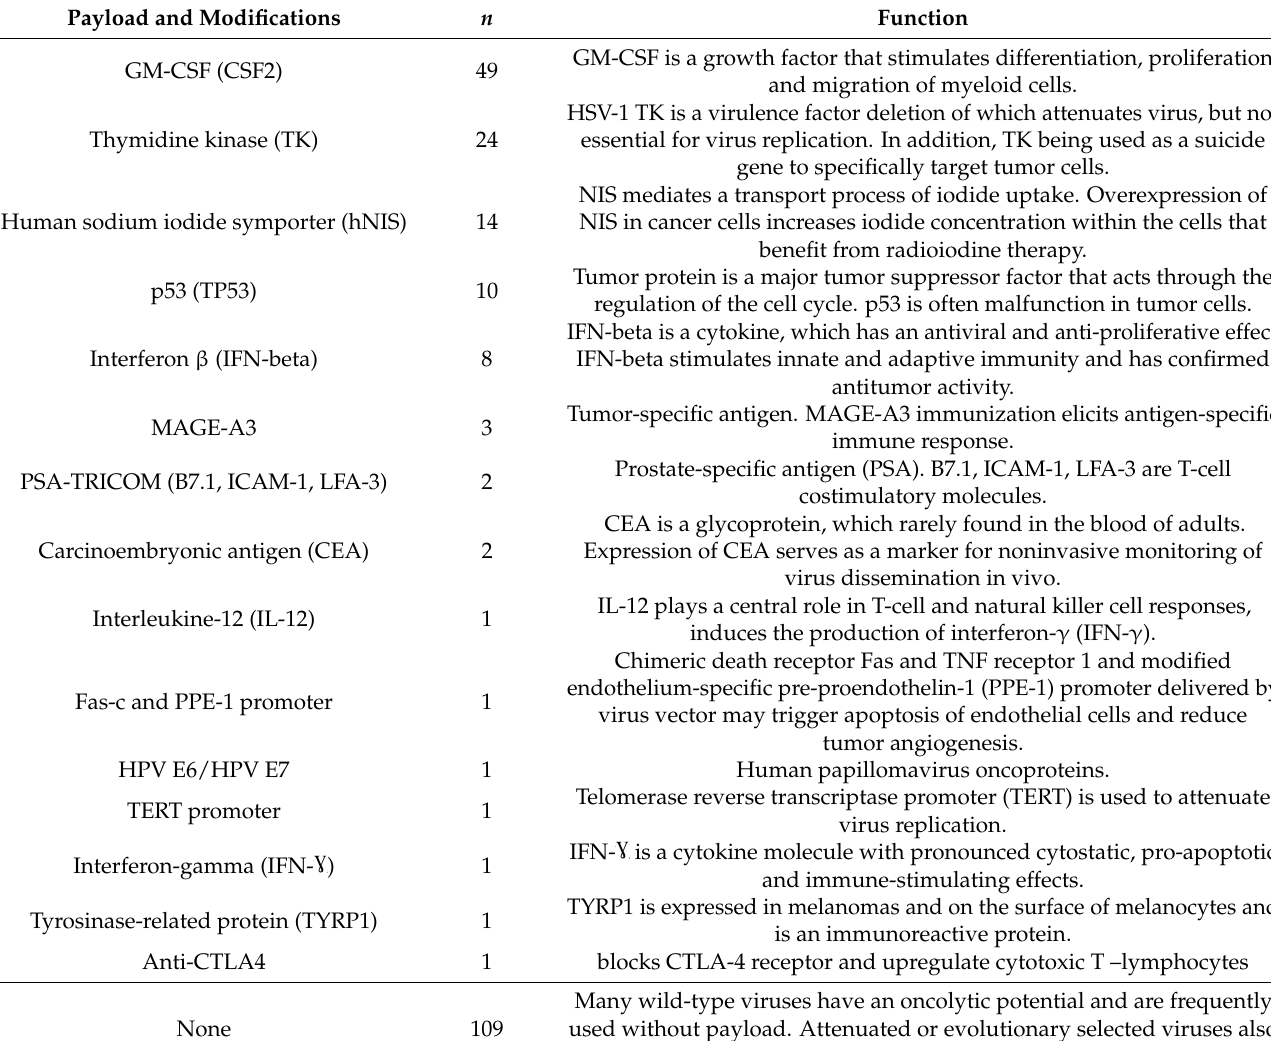
Table 2. Oncolytic viruses engineering and payloads in clinical practice.